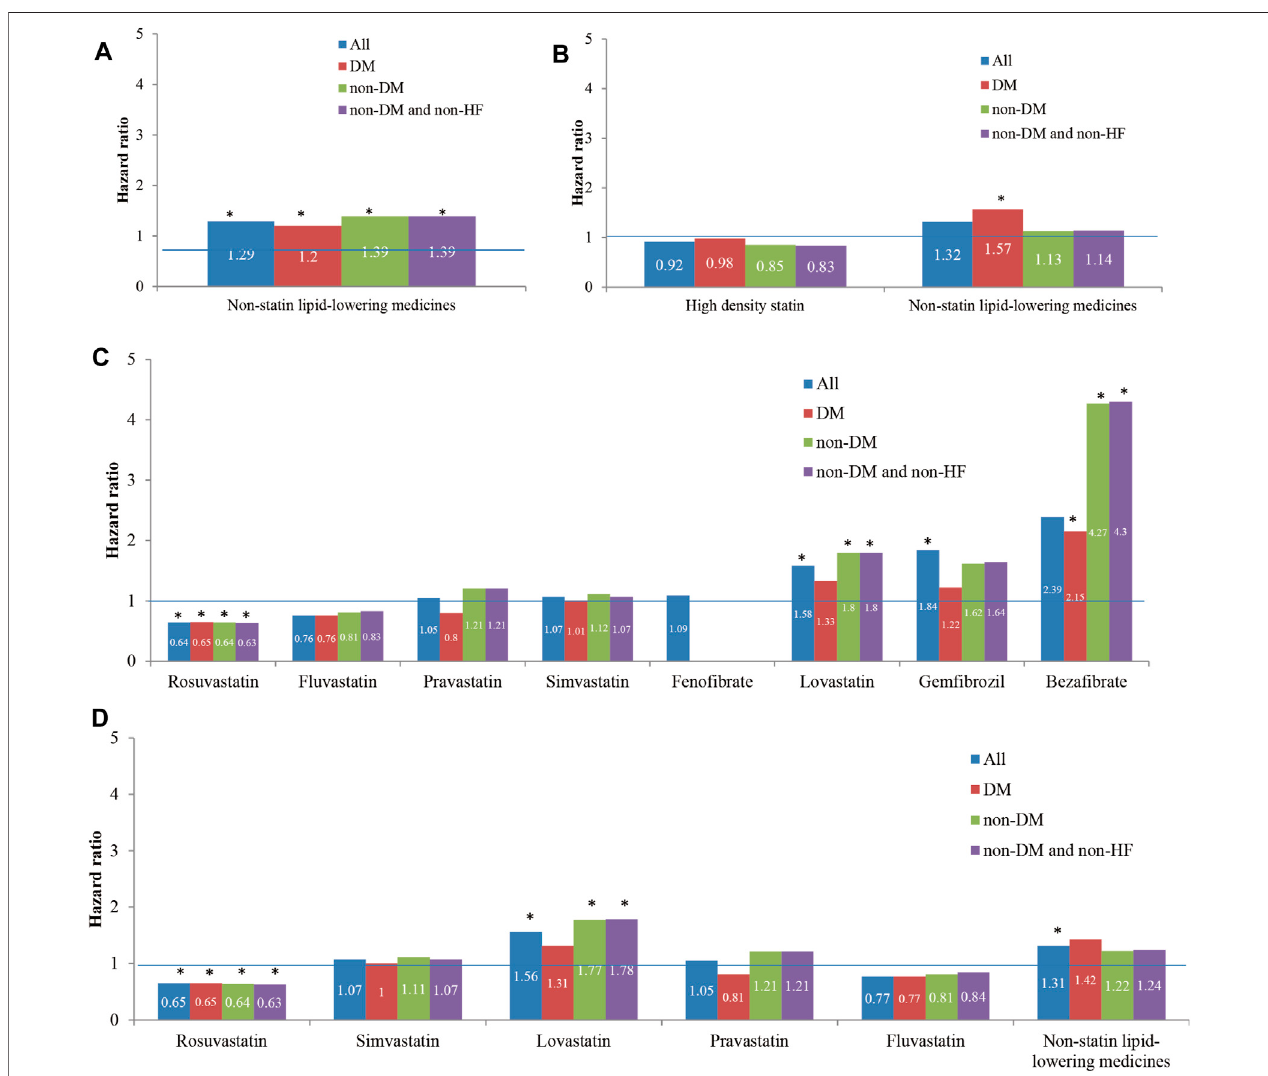
FIGURE 3 | The hazard ratios of reHospIS for hyperlipidemic patients grouped by comorbidities (diabetes mellitus, DM, and heart failure, HF) and categories of lipid-lowering medicines they took regularly using multivariable Cox proportional hazards regression. All the hyperlipidemic patients were categorized into four patient subgroups of 1) all hyperlipidemic patients, 2) hyperlipidemic patients with DM, 3) non-DM hyperlipidemic patients, and 4) non-DM and non-HF hyperlipidemic patients. Cox proportional hazards regression model of each medicine category was conducted for each patient subgroup. The medicine categories were described as follows: (A) nonstatin lipid-lowering medicines versus statins (reference group, ref); (B) high-density statins (Atorvastatin, Rosuvastatin, and Simvastatin) and nonstatin lipid-lowering medicines versus low-density statins (Beza fi brate, Gem fi brozil, and Feno fi brate) (ref); (C) Rosuvastatin, Simvastatin, Lovastatin, Pravastatin, Fluvastatin, Beza fi brate, Gem fi brozil, and Feno fi brate versus Atorvastatin (ref); (D) fi ve individual statins of Rosuvastatin, Simvastatin, Lovastatin, Pravastatin, and Fluvastatin versus nonstatin lipid-lowering medicines (ref). The asterisk represents a statistically signi fi cant hazard ratio ( p < 0.05). Signi fi cant variables in the univariable Cox proportional hazards regression models were selected and entered in the multiple Cox proportional hazards regression